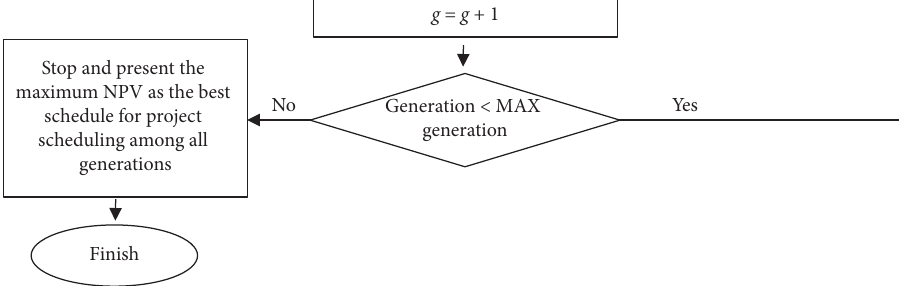
Figure 1: Conceptual flowchart of optimization process by